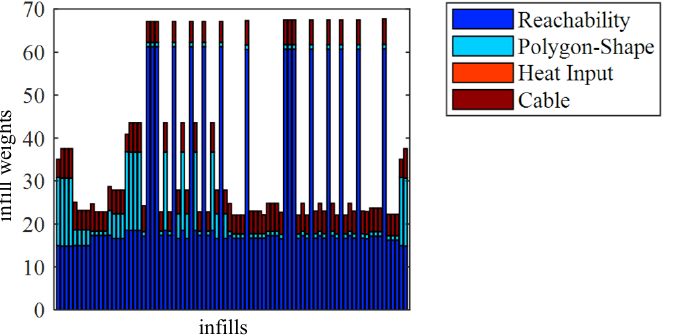
Figure 20. Infill weight combination of the example slices in Figure 7. Pre-processing was done only with standard zigzag. The results in heat input weights are equal to zero for the current